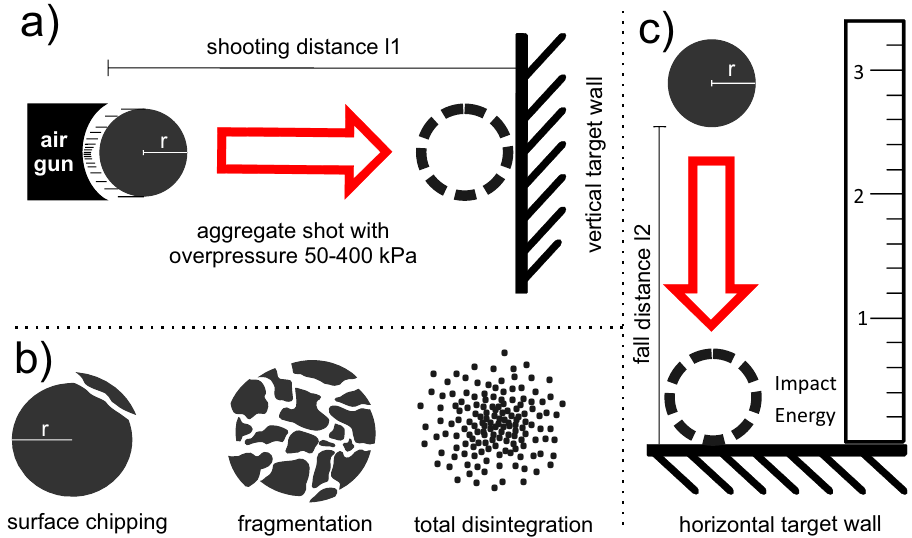
Figure 1. ( a ) Pressurized air-gun setup at Aarhus University, Denmark. Aggregates were shot with overpressure against a vertical metal wall. Applied overpressures ranged between 0.5 and 4 bar, resulting in impact velocities of 2.9–7.8 m.s − 1 . ( b ) Impact setup at LMU Munich, Germany. Aggregates were dropped from heights between 5 and 200 cm onto a metal plate. Impact speed was monitored with a high-speed camera and used to calculate impact energy. ( c ) Modes of break-up that were observed throughout experiments: surface chipping ( < 10 wt% loss of material from parent aggregate), fragmentation (10–90 wt% material loss from parent aggregate) and total disintegration ( > 90 wt% material loss from parent